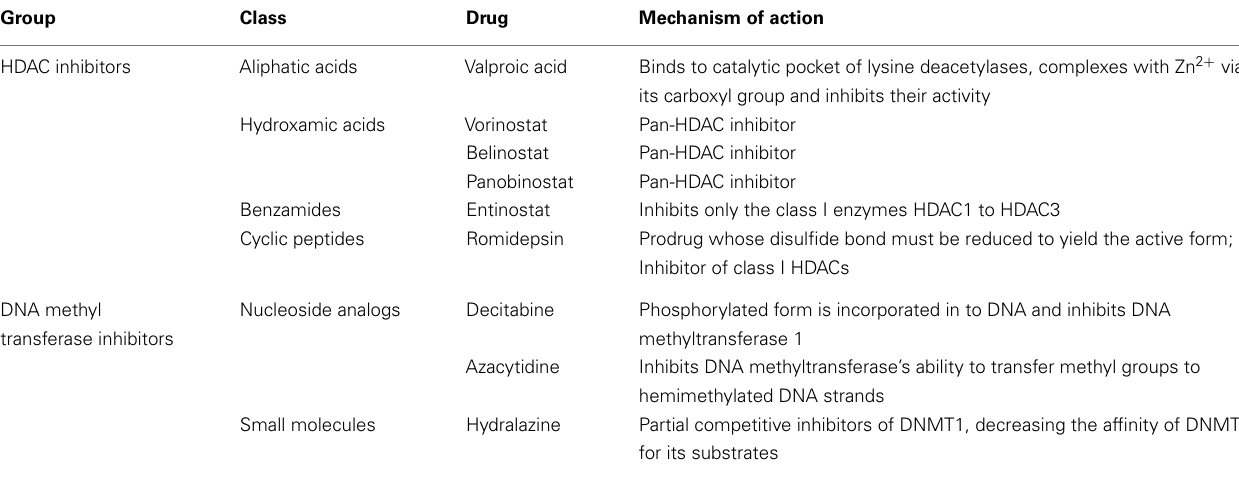
Table 1 | Selected epigenetic drugs which are undergoing clinical evaluation in lung